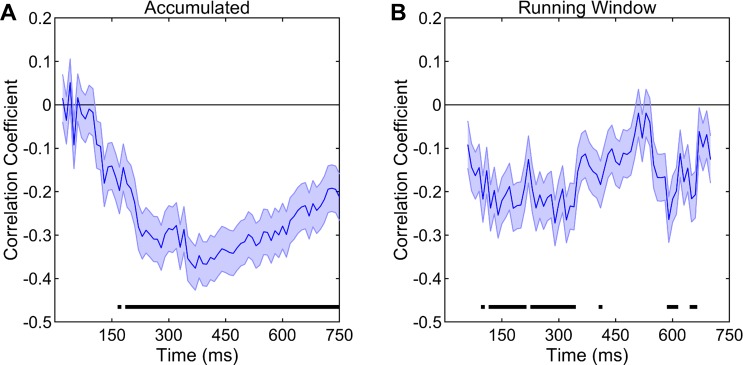
Correlations between adaptation rates and the slopes of correct neural decoding probabilities.(A) The correlations between adaptation rates and the slopes of correct neural decoding probabilities for presentations 1–6 were negative during response windows starting from the stimulus onset and ending at the 17th time bin or further (170–750 ms). (B) When the same relationship between the two variables was assessed using a 110-ms running response window, the correlations were negative for several response windows, majority of which were mostly centered between the 10th and the 30th time bin (100–300 ms). Shadings indicate standard error of correlation coefficients. Horizontal black bars denote significant correlations.